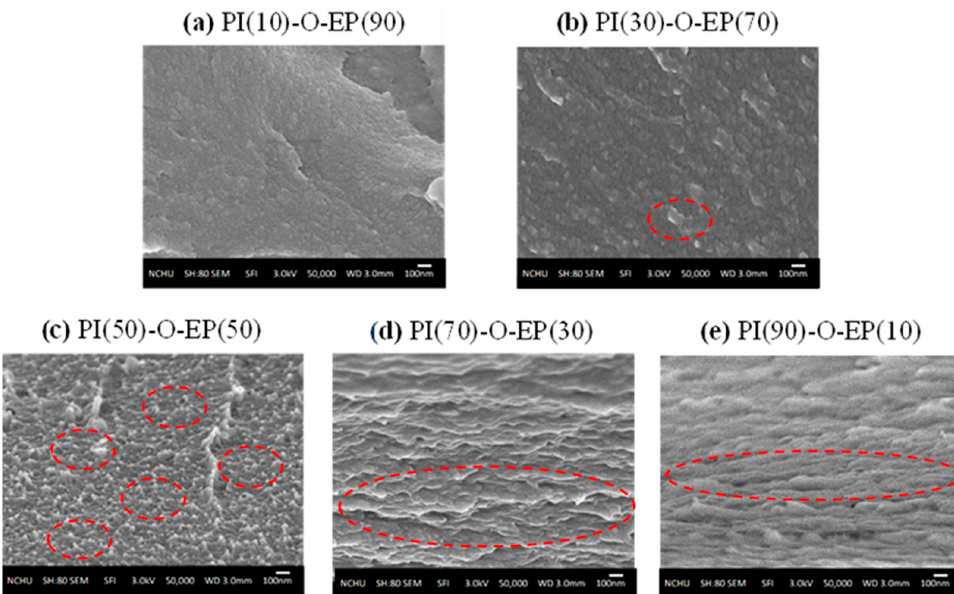
Figure 6. SEM of PI-O-EP (numbers in parenthesis are weight %); red circles mark typical microphase separation.